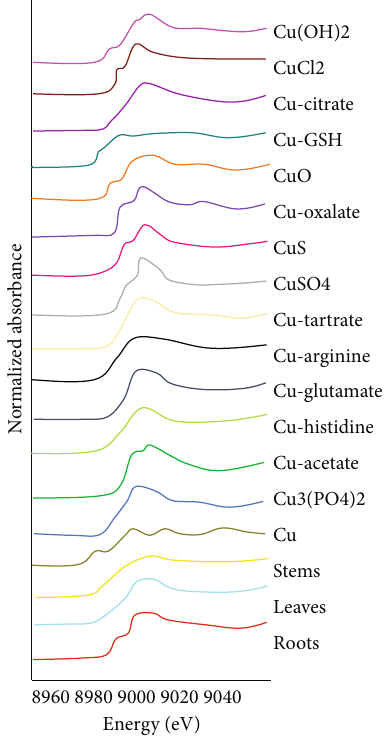
Figure 6: Cu-XANES spectra of di ff erent tissues and standard samples of willow treated with 24mg/L CuSO